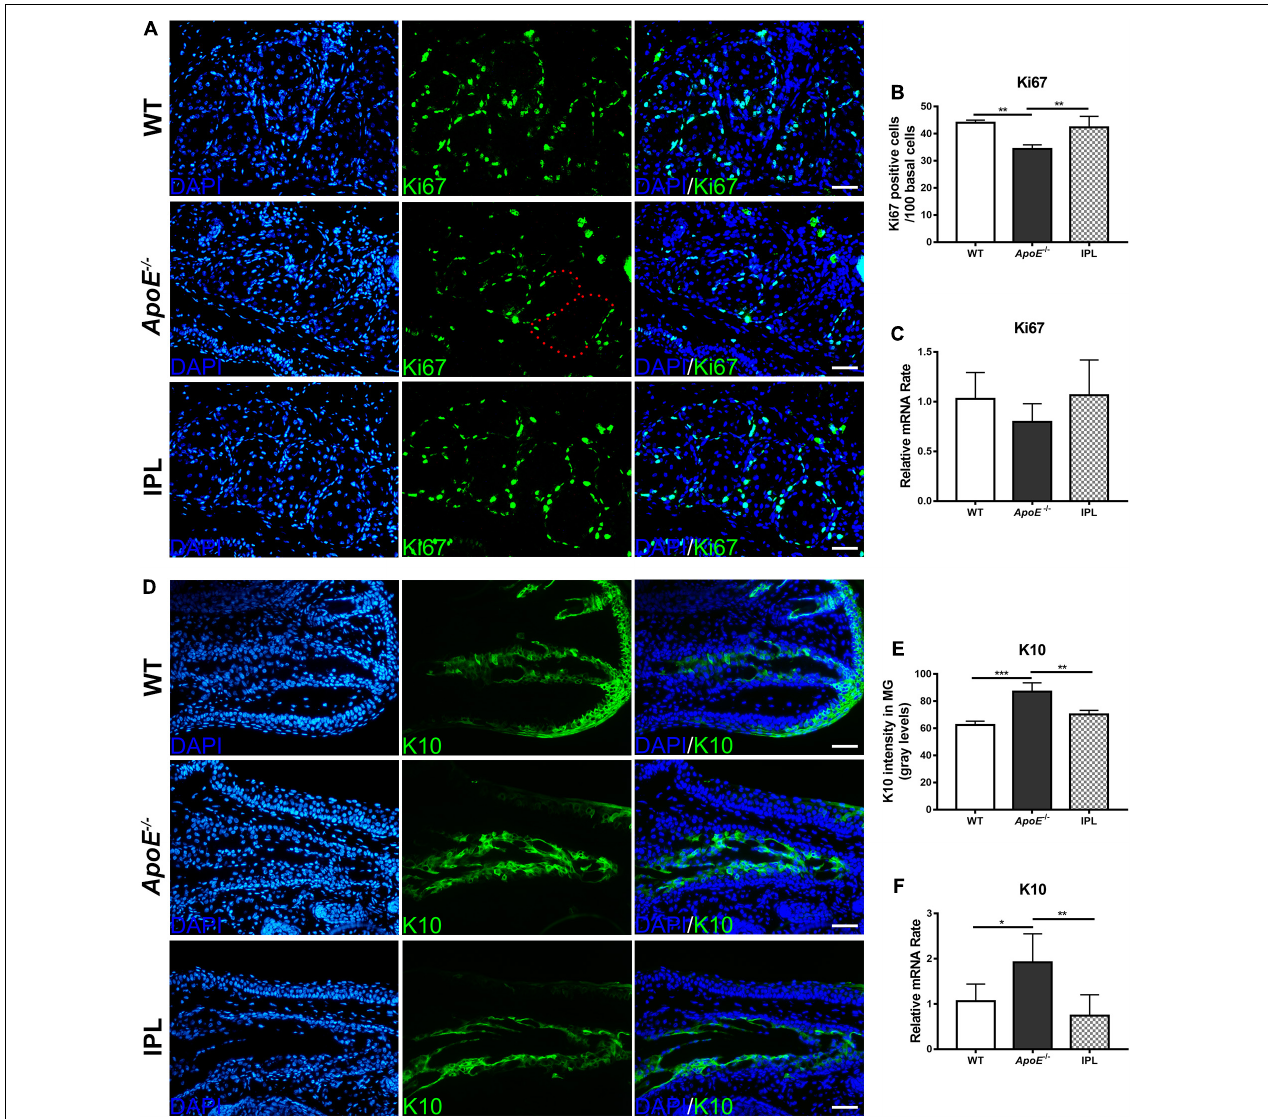
FIGURE 5 | Increased proliferation and decreased keratinization in MGs after IPL treatment. (A) Images of Ki67 immunofluorescence staining. The red dotted line indicates that basal cells were Ki67 negative. (B) The counting number of Ki67-positive basal cells in MGs ( n = 3/group). (C) Ki67 gene expression ( n = 5–6/group). (D) Images of K10 immunofluorescence staining. (E) Quantification of K10 expression in the ducts of MGs ( n = 3/group). (F) K10 gene expression ( n = 5–6/group). * p < 0.05, ** p < 0.01, *** p < 0.001. Scale bars: 50 µ